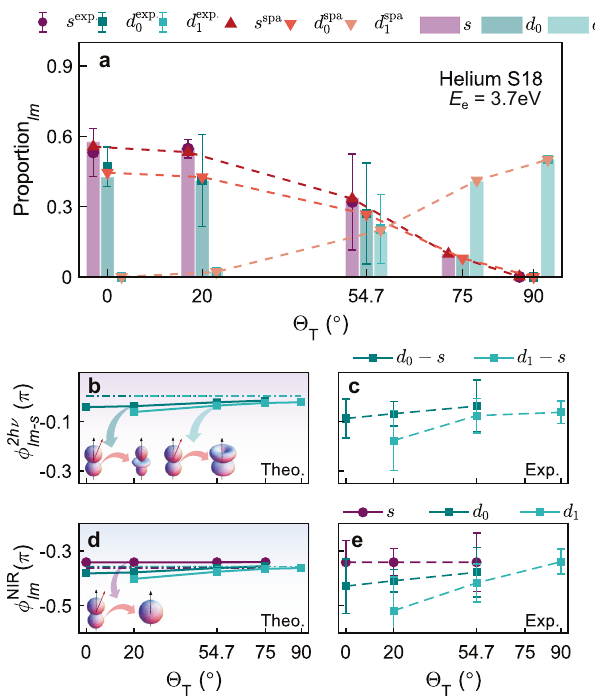
Fig. 3 | Full partial-wave analysis of helium. a The proportions of m -resolved partial waves averaged over all pump-probe time-delays as a function of the skew- angle Θ T . The purple circles, dark-cyan and turquoise squares show the complex fi tting results from experiments of s , d d 0 - and 1 -wave, and the bars with the same color display the RMT simulation. The red triangles represent the SPA predictions. b , c The m -resolved phase shift difference between d -waves and s -wave from ( b ) theory and ( c ) experiment. The dot-dashed lines display the results with I NIR =0.1 TW/cm 2 . d , e The m -resolvedcontinuum-continuumphaseshiftsfrom d theoryand e experiment.Theerrorbarsrepresentthestandarddeviation.Theinsetsshowthe quantum transition pathways along b p 0 → d 0 or d 1 , d p 0 → s . Owing to the identical phaseproperty between d +1 and d − 1 wave inour RMTsimulation, we use d 1 to refer to both the d ±1